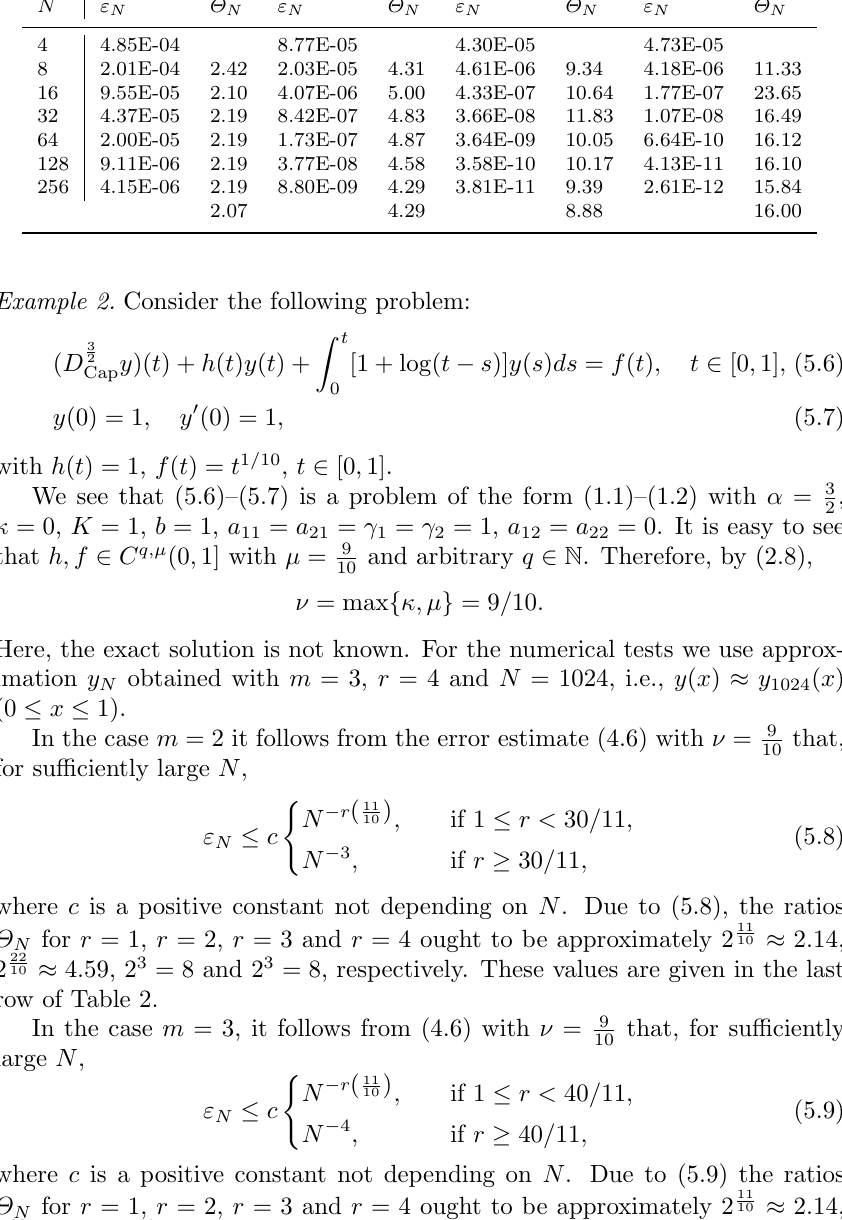
Table 1. Numerical results for problem (5.3)–(5.4) with m = 3. r = 1 r = 2 r = 3 r = 4 N ε N Θ N ε N Θ N ε N Θ N ε N Θ